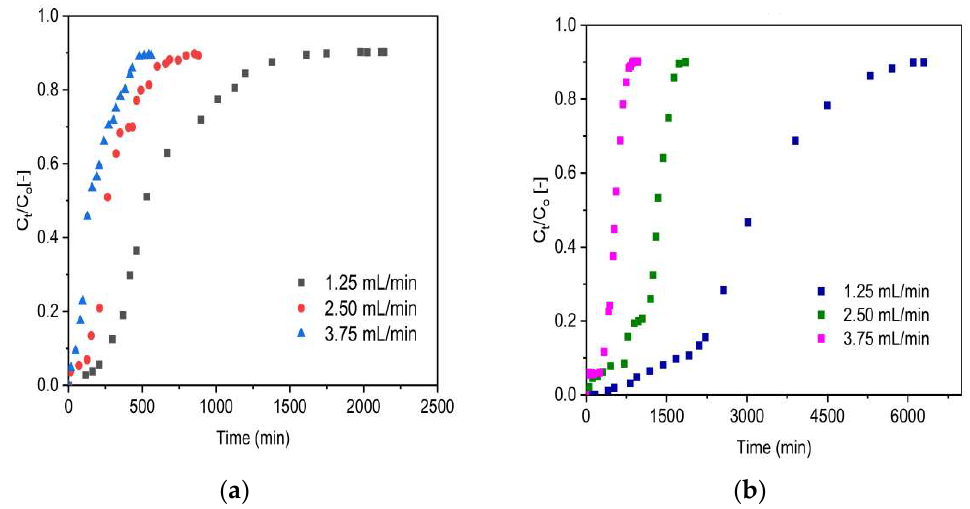
Figure 6. Effect of initial flow rate on the fluoride breakthrough ( a ) VSco and ( b ) ZrOCSc (pH 2; C O : 10 mg/L; bed depth 10 cm). 10 mg/L; bed depth 10